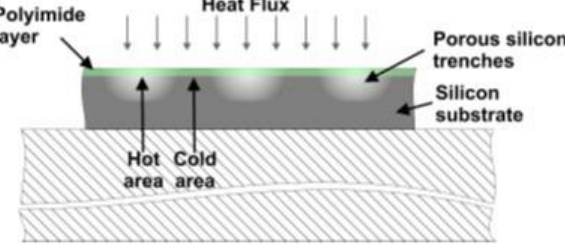
Figure 1. Cross-sectional view of periodic temperature variations induced by the heat flux.